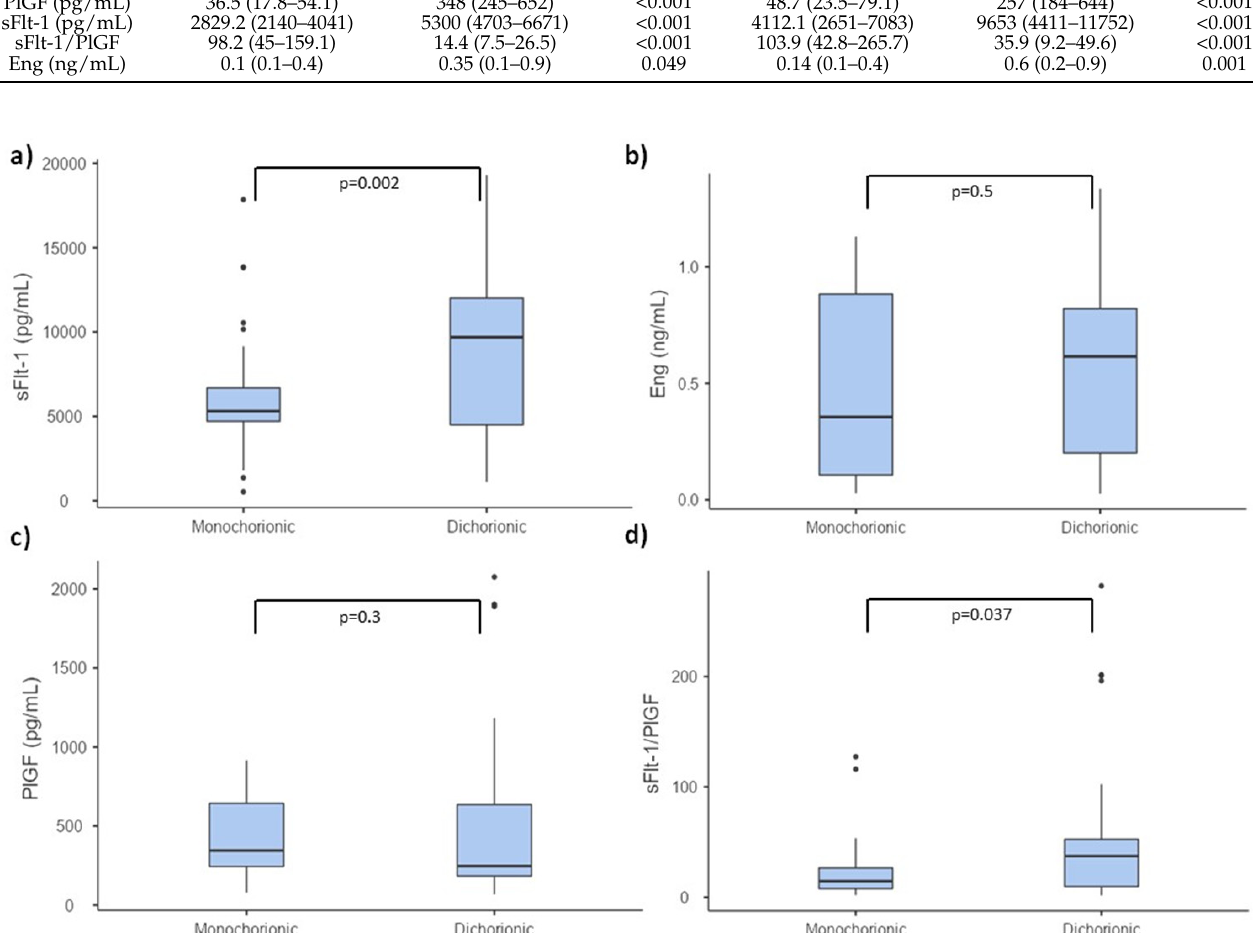
Figure 2. Box-and-whisker plots showing serum values of PlGF, sFlt-1, sFlt-1/PlGF ratio and sEng measured in the third trimester of twin pregnancy. ( a ) sFlt-1; ( b ) sEng; ( c ) PlGF; ( d ) sFlt-1/PlGF serum concentration.